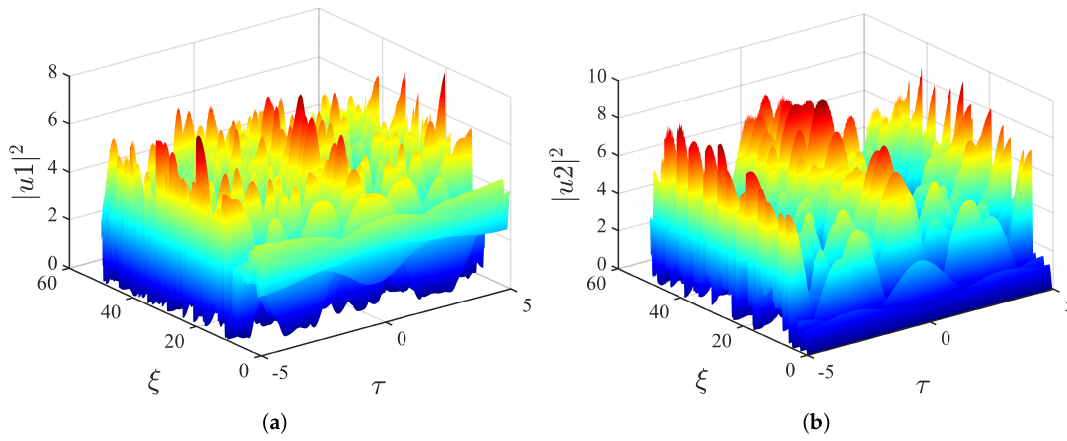
Figure 23. Creation of a chaotic (turbulent) state by the MI in the bar ( a ) and cross ( b ) channels in the normal-GVD dispersion regime ( σ = − 1) for CW amplitudes A 1 = 2, A 2 = 0.001, with perturbation parameters a 0 = 0.09, ω 0 = 1. Other parameters are α = 2, Γ = 0.5, ρ = 0.01, χ = 0.02 and κ =